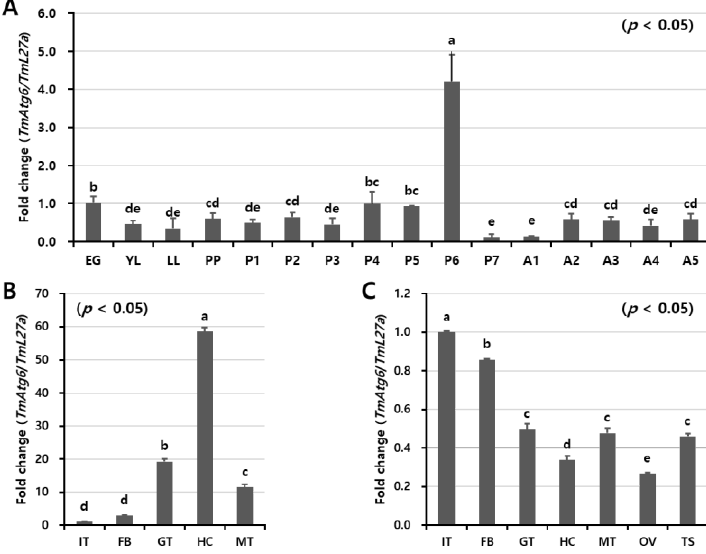
Figure 3. Developmental and tissue-specific expression patterns of TmAtg6 gene. ( A ) The developmental stages of mealworm, egg (EG), young larvae (YL), late larvae (LL), pre-pupa (PP), 1 – 7-days old pupae (P1 – P7), and 1 – 5-days old adult (A1 – A5), were examined to study the expression level of TmAtg6. For each stage, 20 individuals were used to extract RNA with the subsequent synthesis of cDNA. The results indicate that TmAtg6 expression was gradually increased from young larvae to 2-days old pupae with highest expression at the 6-days old pupal stage. In adult stages, there was no considerable expression difference. Tissue-specific expression patterns of TmAtg6 genes in late larvae ( B ) and in 5-day-old adults ( C ) . Hemocytes, gut, fat body, Malpighian tubules, and integument (for late instar larvae and adults), and testes and ovaries (for adults) were dissected and collected from a total of 20 late larvae and 5-day-old adults. The results indicate that TmAtg6 was highly expressed in hemocytes, while low expression was observed in the integument and fat body in late larvae. In adults, the expression levels of TmAtg6 were high in fat body and integument. IT; integument, GT; gut, FB; fat body, HC; hemocytes, MT; Malpighian tubules, OV; ovary, and TS; testis. Tenebrio ribosomal protein 27a ( TmL27a ) was used as internal control.